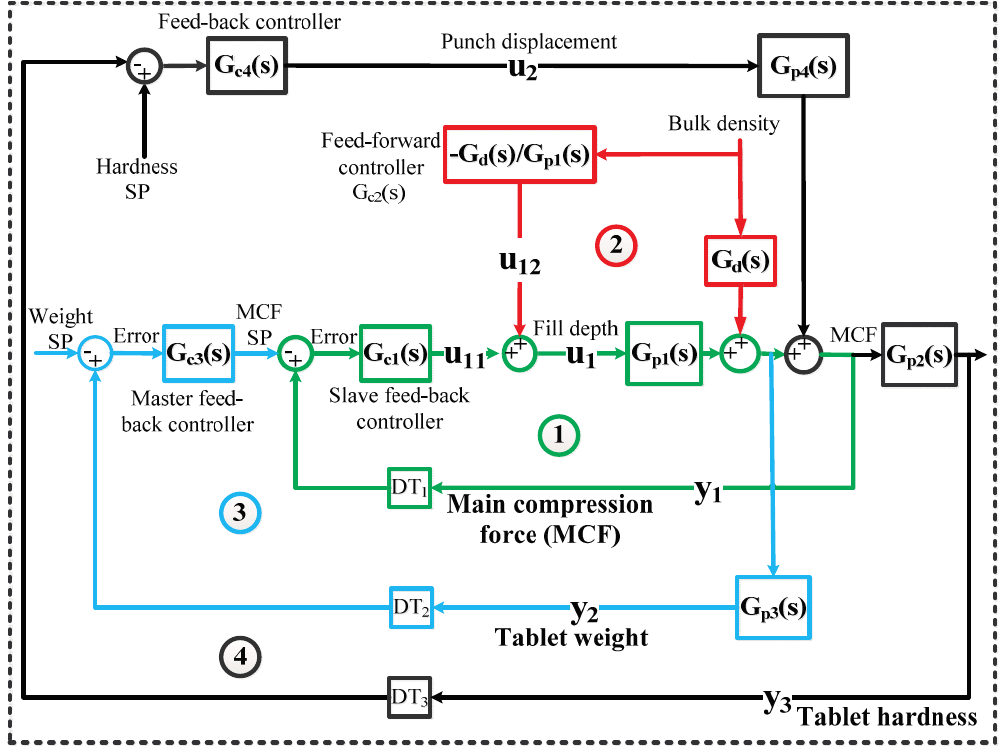
Figure 4. Architecture of the feed-forward/feed-back control system and decoupled tablet weight and hardness control loops. SP: Set point; MCF: Main compression